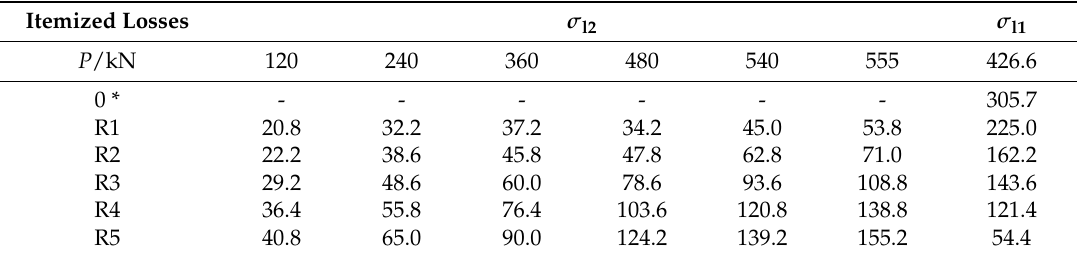
Table 8. σ l2 and σ l1 calculated from the strains of the LFBG sensors at Step I. (Unit: MPa). Itemized Losses